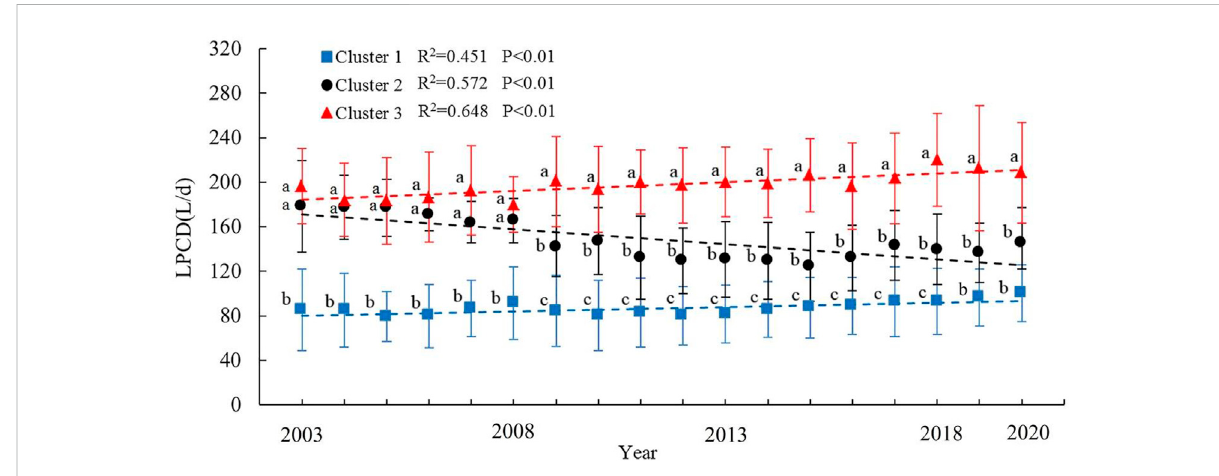
FIGURE 6 Comparison of liters per capita per day in clusters 1, 2, and 3. Note: The bar represents the mean ± standard deviation.